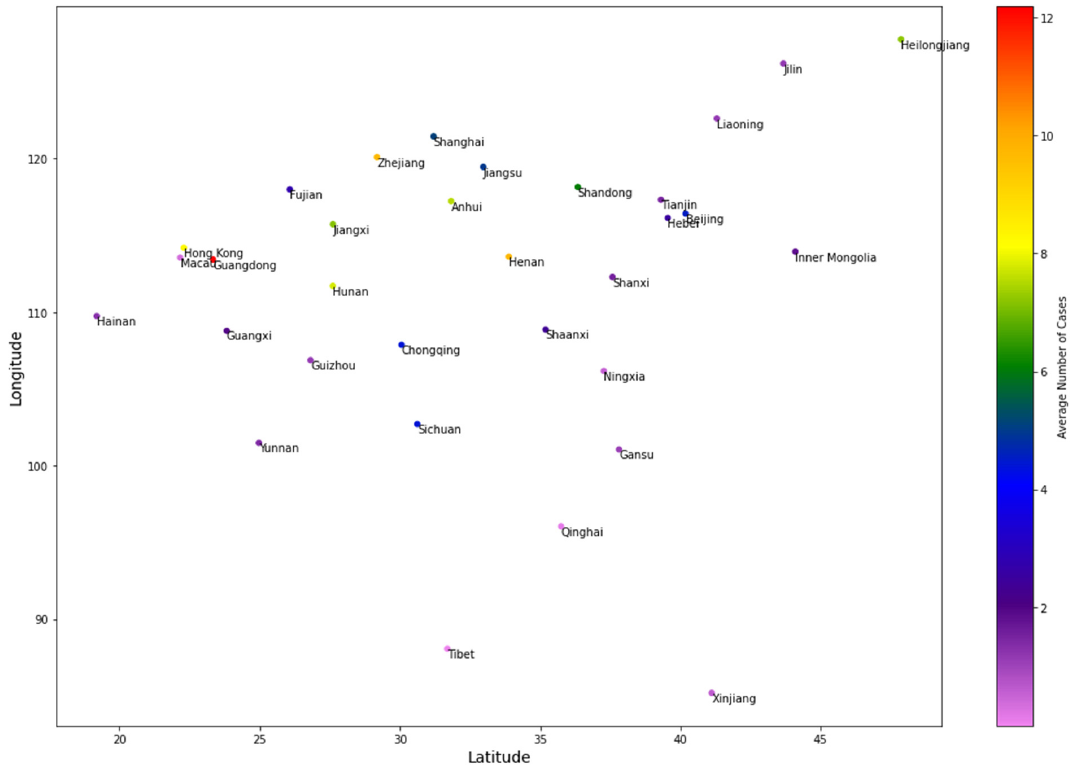
Figure 2. Spatial plot of average number of